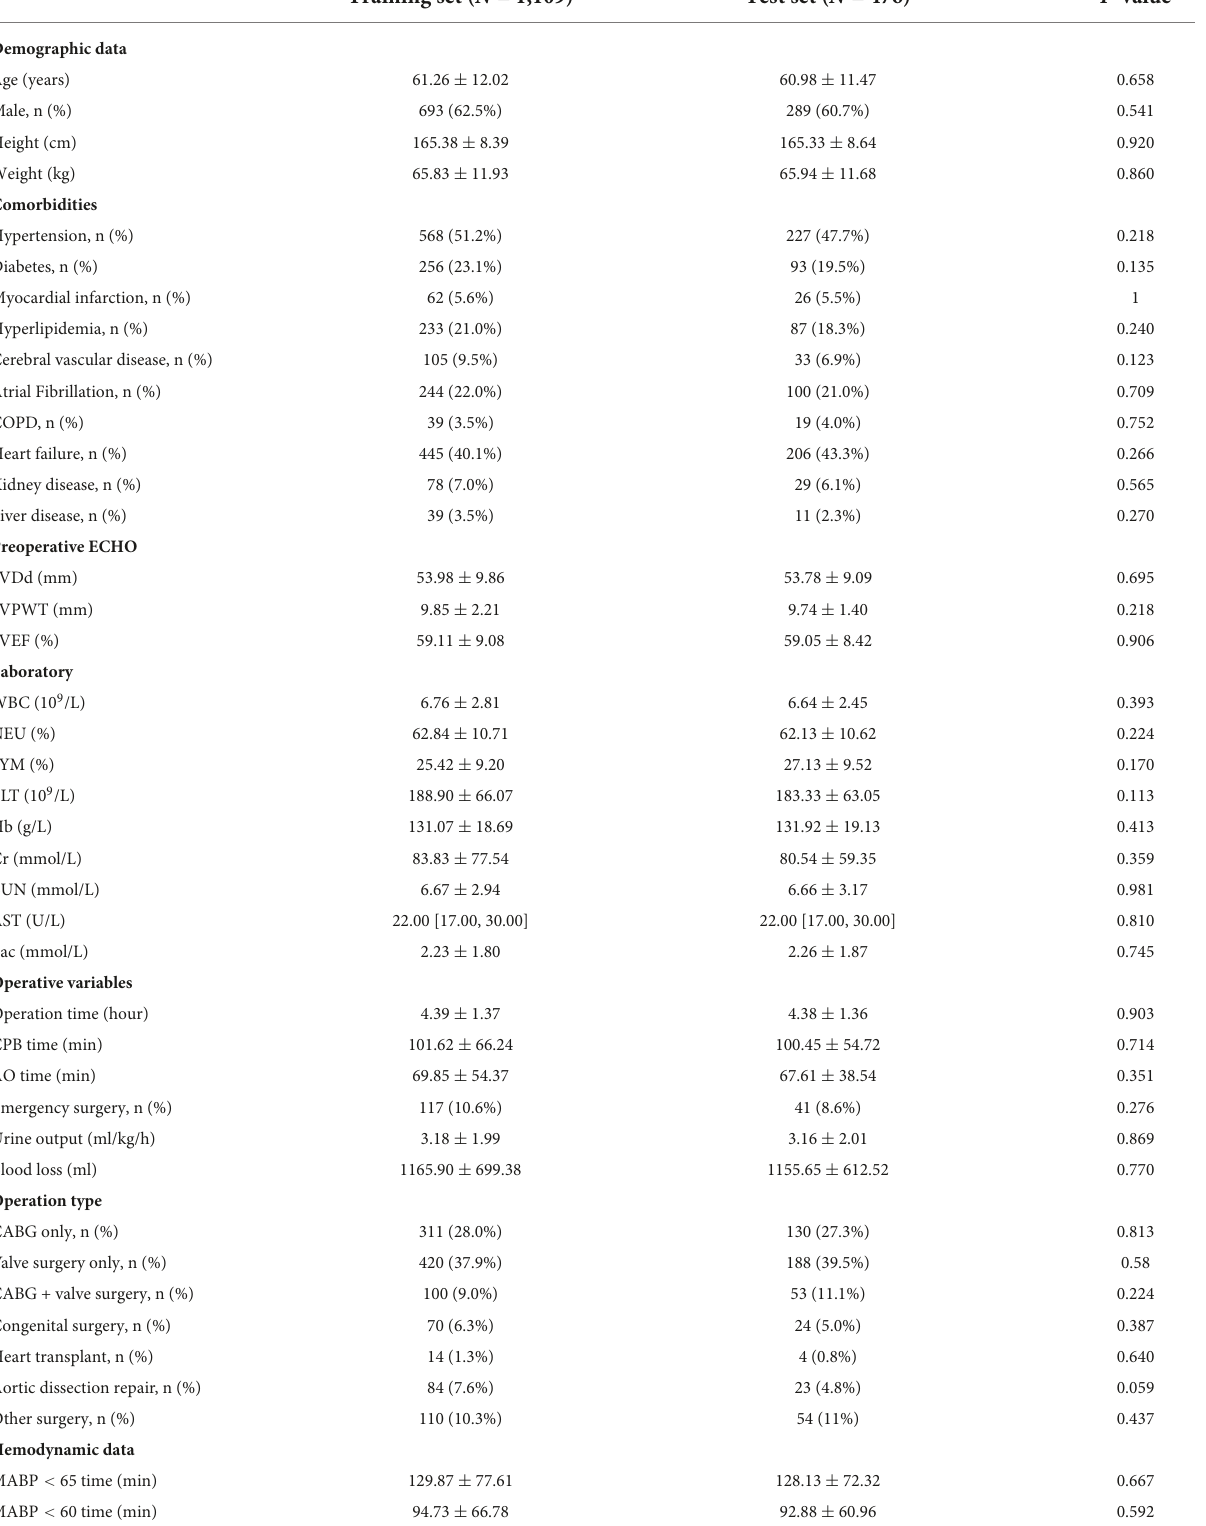
TABLE 1 Patient characteristics and clinical